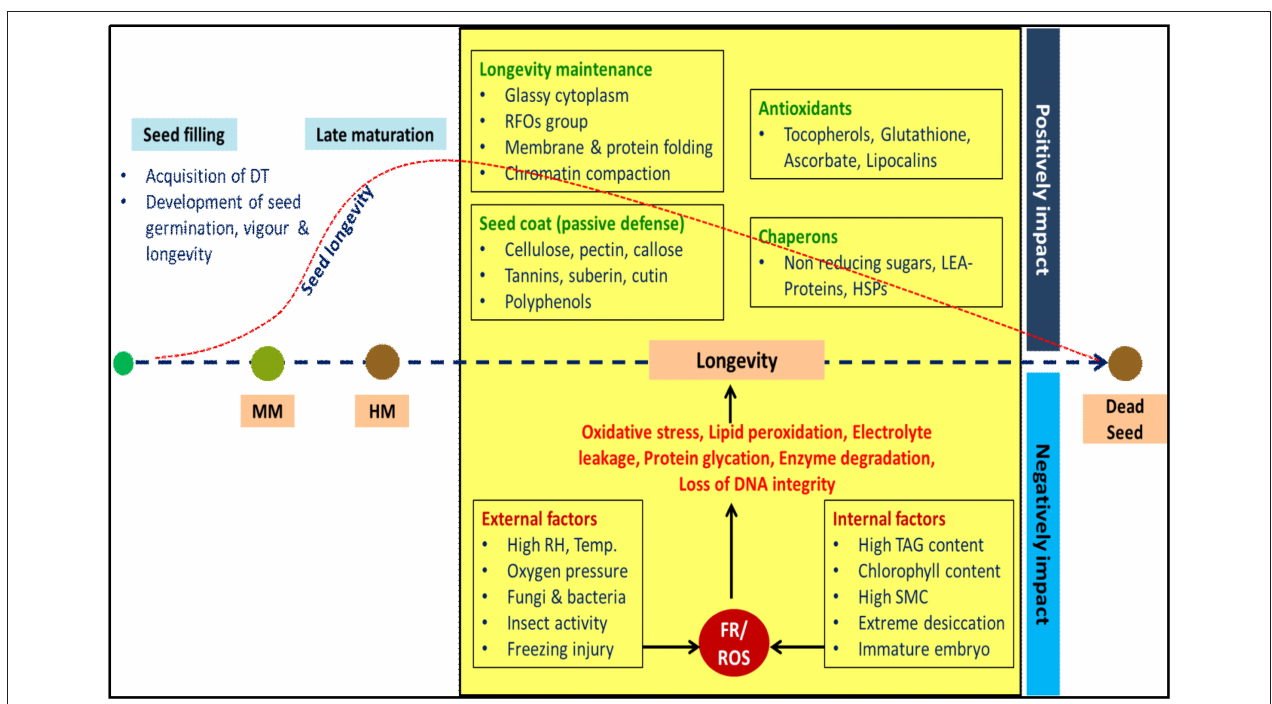
FIGURE 1 | Schematic representation of interplay between factors determining seed longevity. Seed attains maximum dry weight during mass maturity (MM). Seed vigour and longevity progressively developed during late maturation phase and reaches maximum during harvest maturity (HM). During dry storage, longevity is a result of interaction between various intrinsic and extrinsic factors. Seed longevity is not indefinite; it decreases gradually and lost completely at some point of time. DT: desiccation tolerance; RFOs: raffinose family oligosaccharides; LEA: late embryogenesis abundant; HSPs: heat shock proteins, RH: relative humidity, TAG: triacylglycerol; SMC: seed moisture content, FR: free radicals, ROS: reactive oxygen